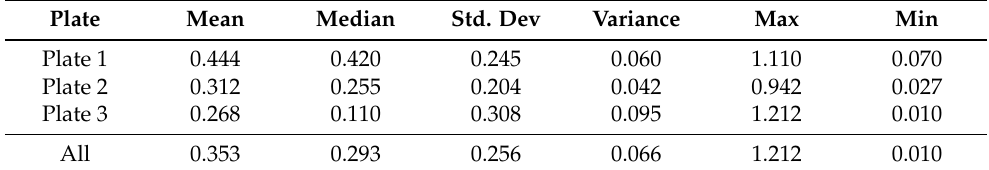
Table 10. Data extracted for the plates with TH.